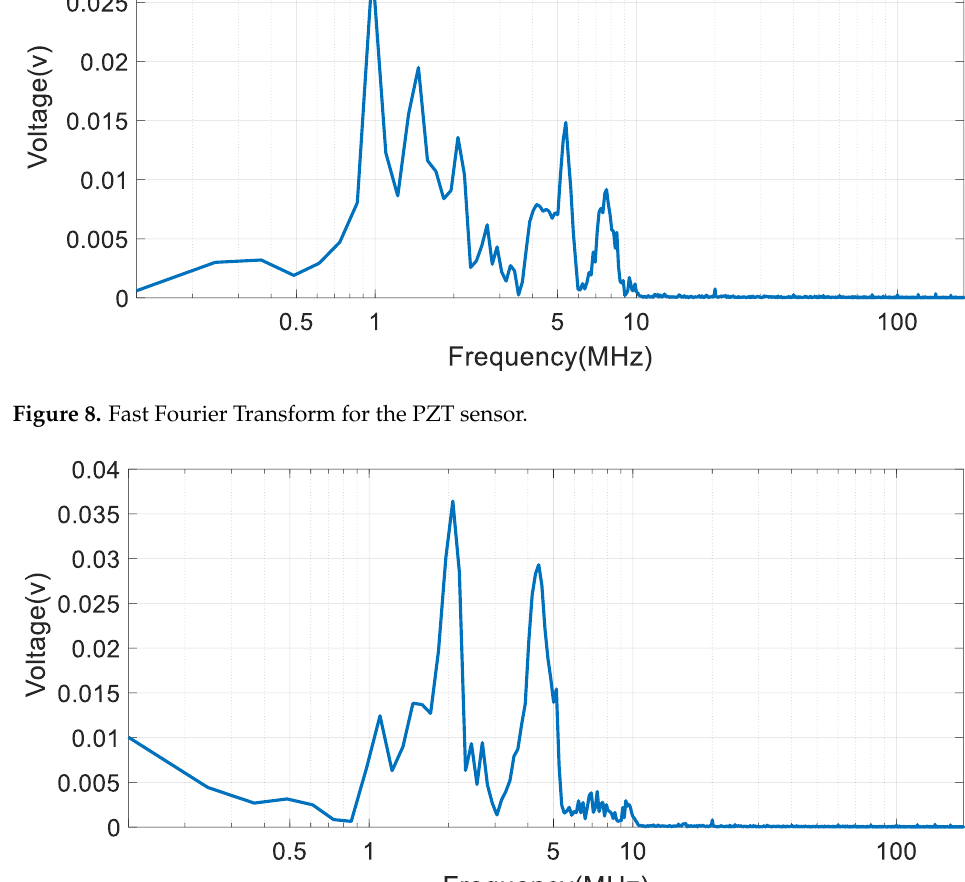
Figure 9. Fast Fourier Transform for the MFC sensor.